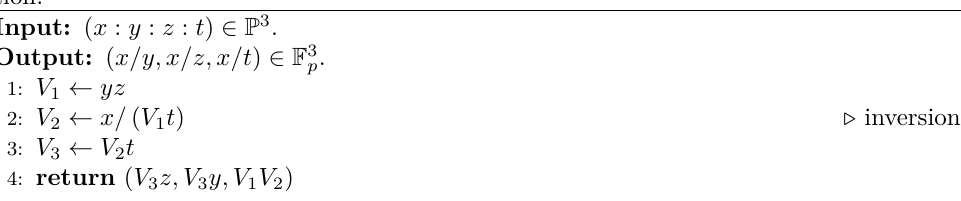
Algorithm 3 wrap : ( x : y : z : t ) 7→ ( x/y, x/z, x/t ) compute wrapped 381-bit representa- tion.